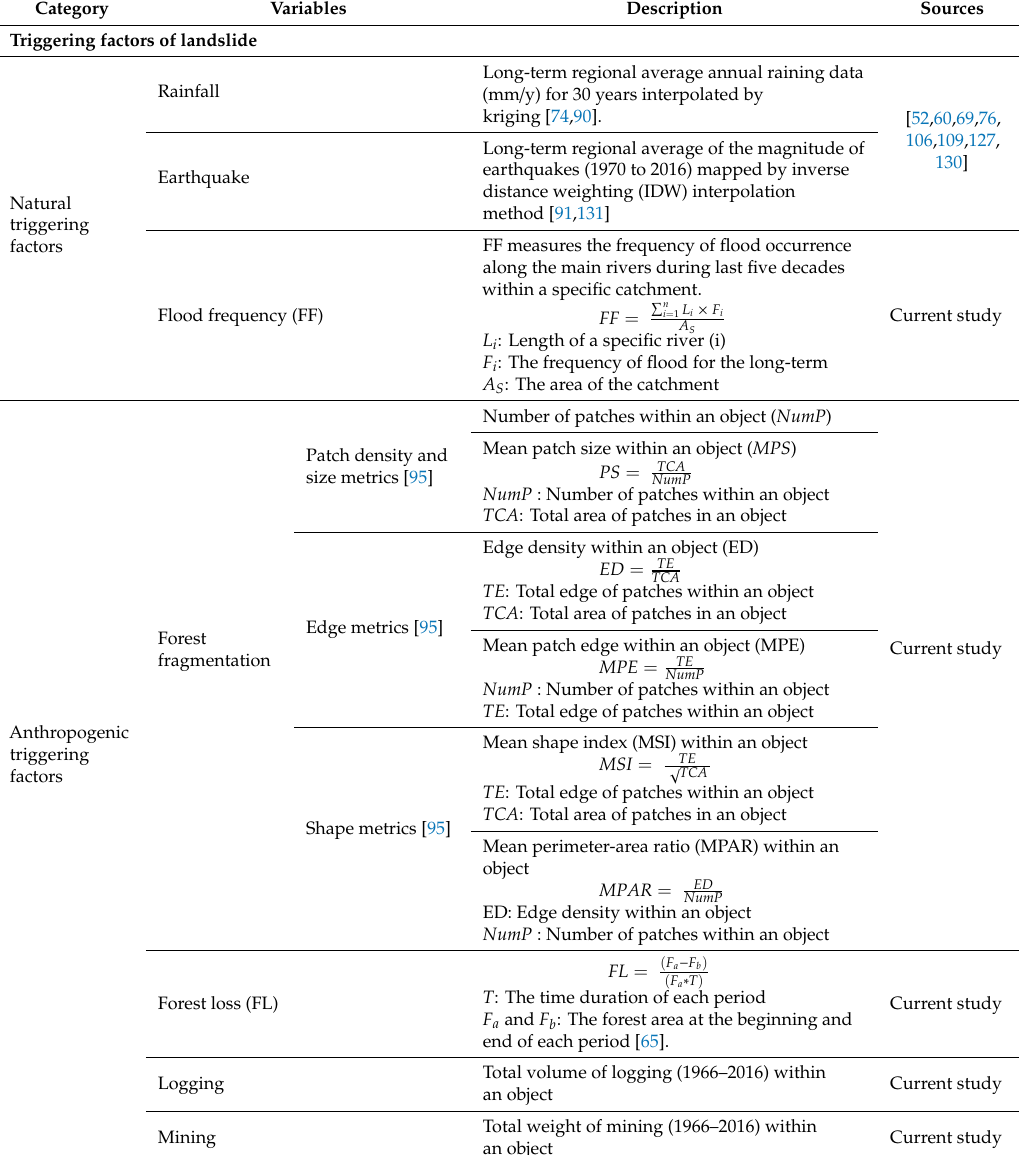
Table 2. Triggering factors for mapping landslide susceptibility used in NE